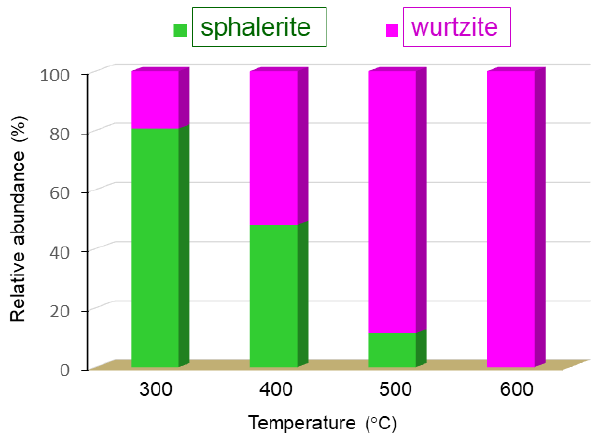
Figure 5. Variation of the relative abundance of the sphalerite and wurtzite forms of ZnO present in film 1e at each annealing temperature.